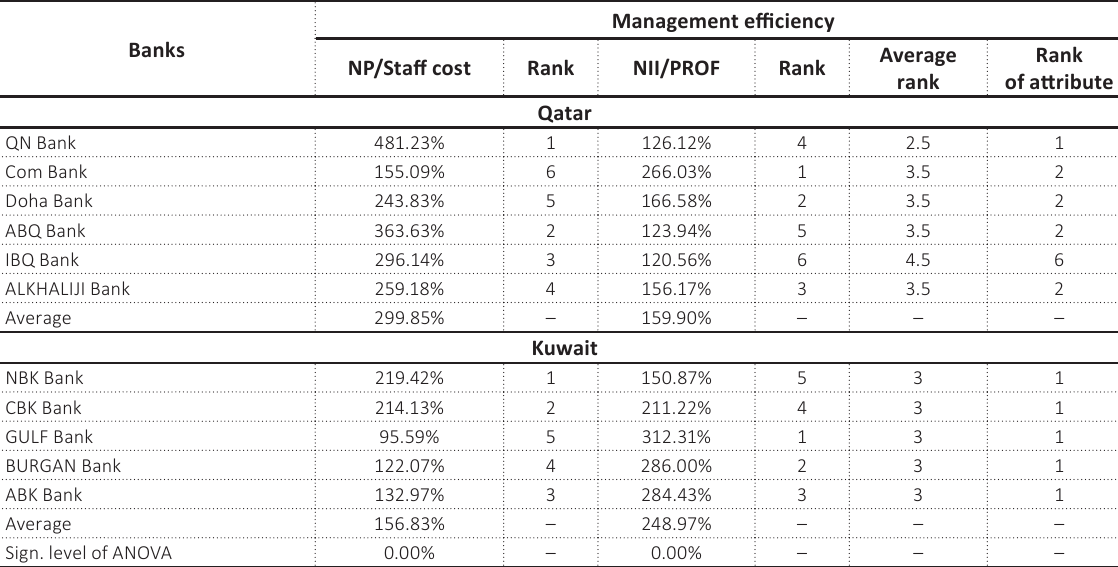
Table 5. Average ratios of years and rankings in the case of the Management efficiency factor at selected